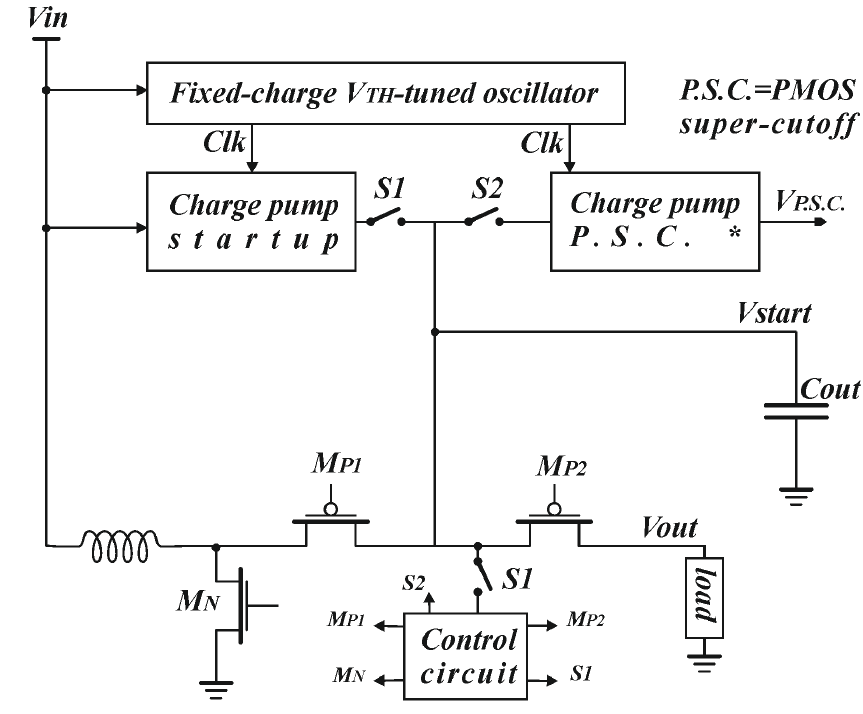
Figure 11. The hybrid converter presented in